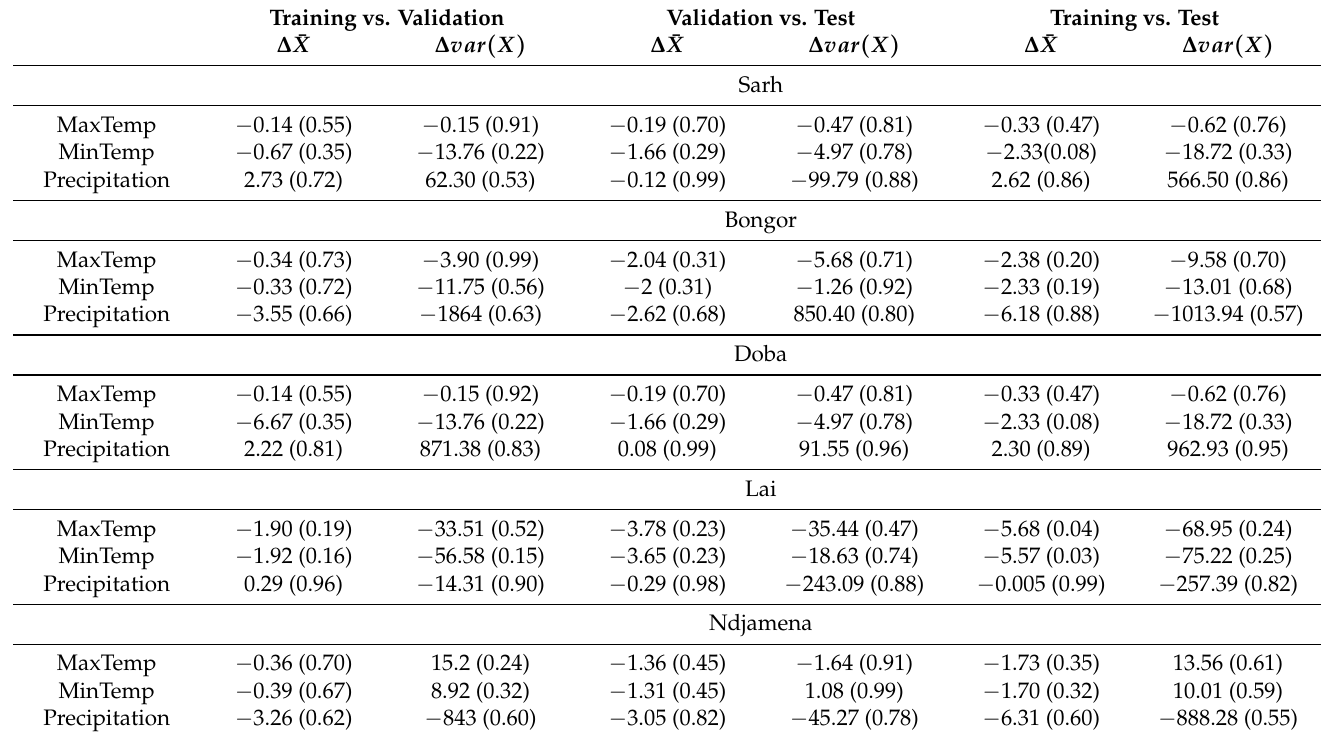
Table 5. The statistical difference of the mean and variance estimation for the five gauging stations between the training, validation and test sets. p -values are given in